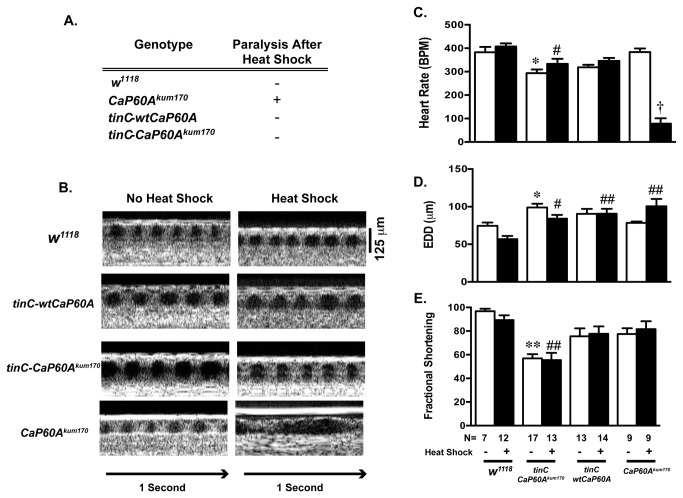
The effects of cardiac specific overexpression of CaP60A
kum170 and wild type CaP60A on cardiac phenotypes.
A. Cardiac specific overexpression of wild type CaP60A (tinC–wtCaP60A) or mutant CaP60Akum170 (tinC-CaP60Akum170) in Drosophila is not sufficient to phenocopy the paralysis phenotype of the global CaP60A
kum170 mutant. Each mutant had two copies of the transgene; B. Representative OCT images from transgenic CaP60A overexpression flies in comparison to w
1118 and global CaP60A
kum170. 125 micron standard and one-second bars are shown. C. Heart rate, D. End diastolic dimensions (EDD), E. Fractional shortening (%) in w
1118, tinC–wtCaP60A and tinC-CaP60A
kum170 and CaP60A
kum170 at baseline and after 10-minute heat shock. No significant differences were noted in the heart rate in either tinC–wtCaP60A or tinC-CaP60A
kum170 at baseline and after heat shock compared to w
1118. *p<0.05, **p<0.005 vs. w
1118 no heat shock, #p<0.05, # # p<0.005 vs. w
1118 with heat shock, † p<0.0001 vs. w
1118 with heat shock, tinC-CaP60A
kum170 with heat shock, tinC-CaP60A
kum170 with heat shock and CaP60A
kum170 no heat shock by one-way ANOVA with Tukey’s multiple comparisons test.